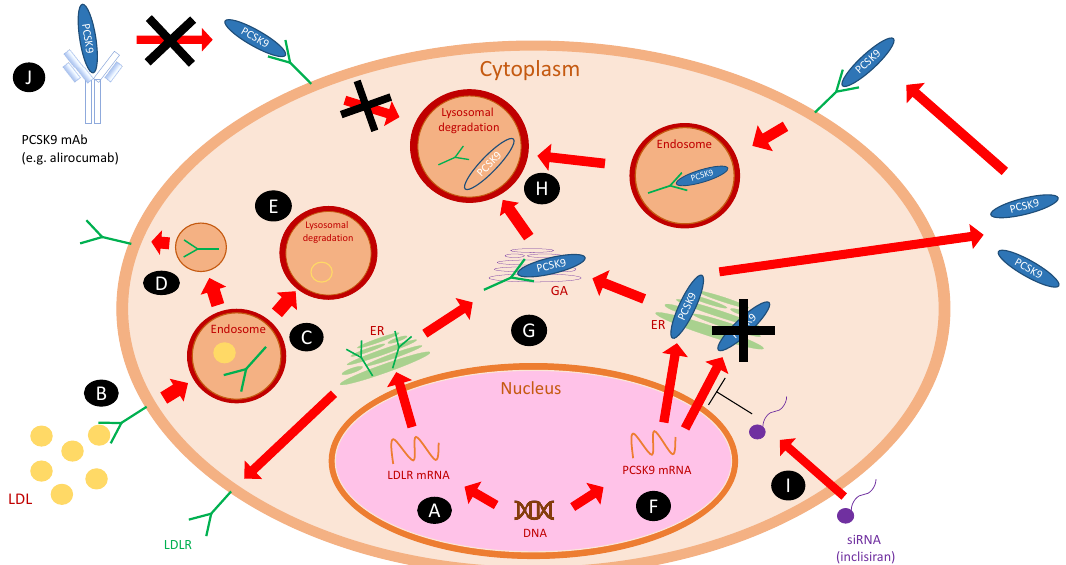
Figure 2. The cellular actions of PCSK9 and its inhibitors on cholesterol metabolism [22]. Abbreviations: ER, endoplasmatic reticulum; GA, Golgi apparatus; LDL, low-density lipoprotein; LDLR, low-density lipoprotein receptor; PCSK9, proprotein convertase subtilisin/kexin type 9; PCSK9 mAb, monoclonal antibody against PCSK9; siRNA, small interfering RNA (inclisiran). ( A ) LDLR gene is transcribed into mRNA, then translated within ER into mature protein and transferred on the cell surface. ( B ) LDL particles, after binding to the LDLRs on the cell surface, are internalized into an endosome. ( C ) As the endosome matures, LDL and LDLR decouple — LDLR ( D ) recycles, and LDL is catabolized in the lysosome ( E) . ( F ) PCSK9 gene is transcribed into mRNA and then translated within ER into the mature protein. It can bind to the LDLR intracellularly within Golgi apparatus ( G ) or be secreted to the extracellular space — both ways lead to lysosomal degradation of LDLR ( H ). ( I ) Inclisiran (siRNA) inhibits the translation of PCSK9 mRNA and prevents the formation of mature protein. ( J ) PCSK9 mAbs (e.g., alirocumab) bind to the soluble PCSK9 in the plasma and prevent from lysosomal degradation of LDLRs.